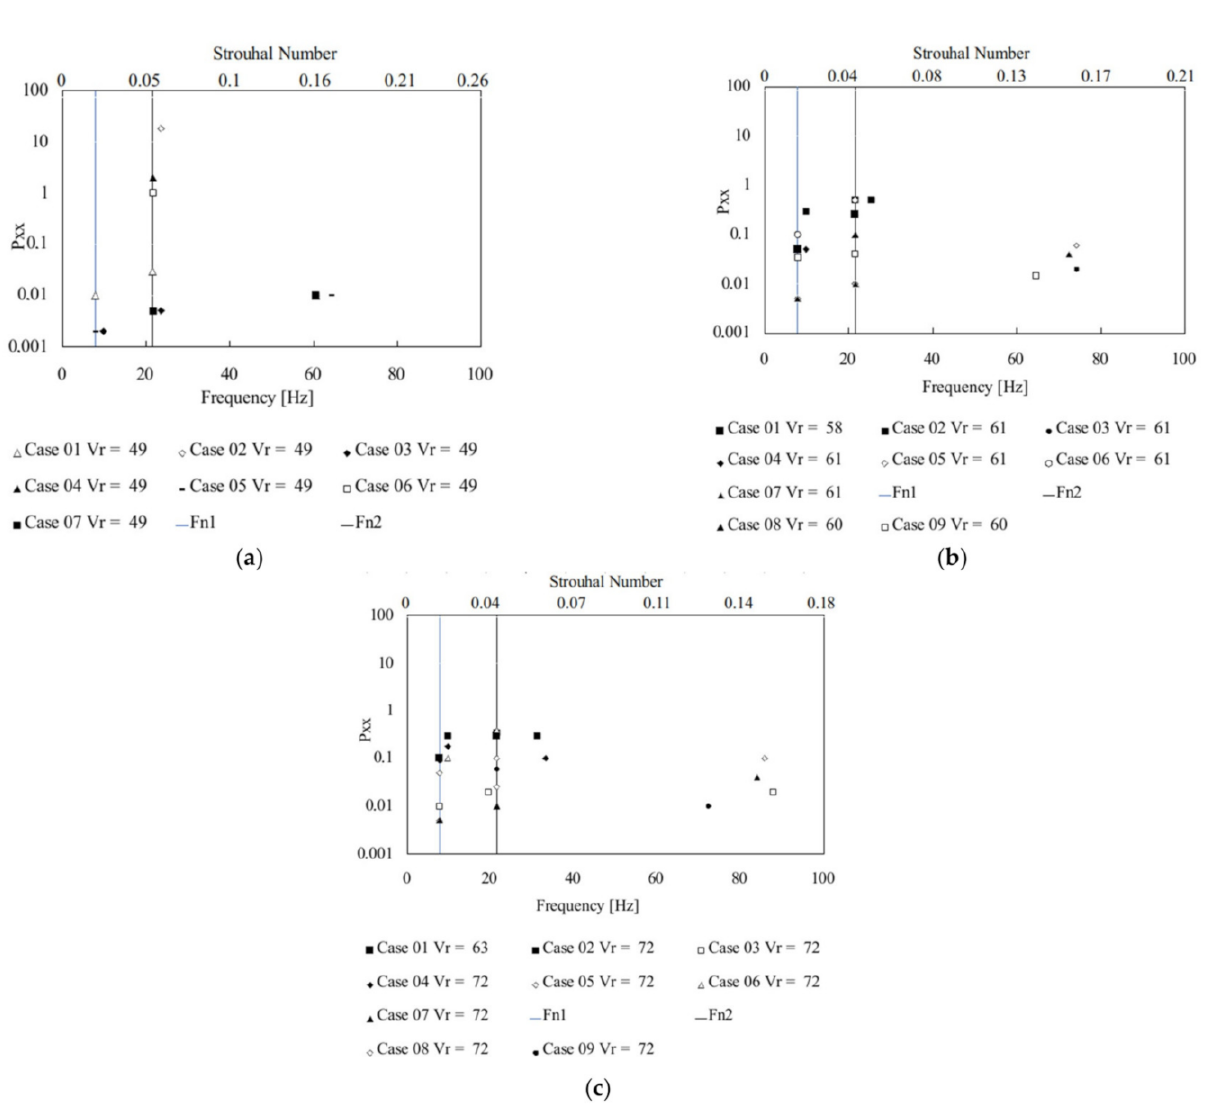
Figure 6. Frequency peaks observed in the Fourier spectrum from acceleration signals for the tested cases with FV and SV in ( a ) reduced velocity around Vr = 49, ( b ) reduced velocity around Vr = 60, and ( c ) reduced velocity around Vr =